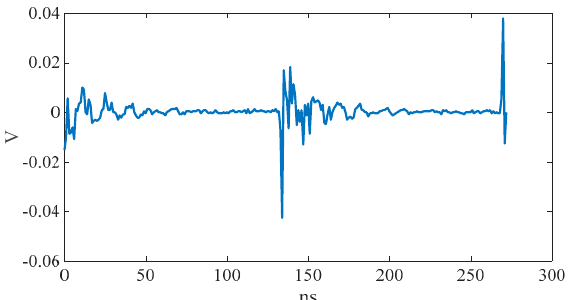
Figure 2. dsPIC33EP512MC202 time domain EM leak (adapted from [10]).